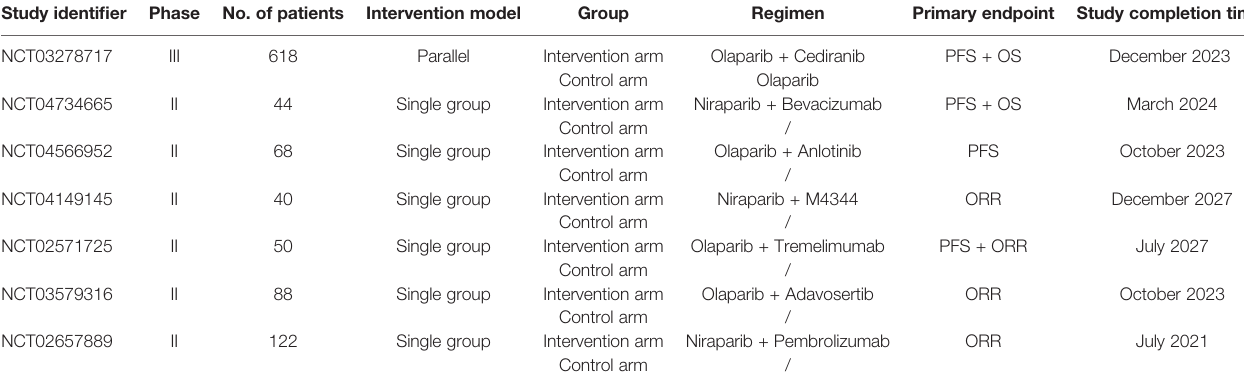
TABLE 3 | Overview of ongoing clinical trials of PARPis in combinations in recurrent ovarian cancer therapy. Study identi fi er Phase No. of patients Intervention